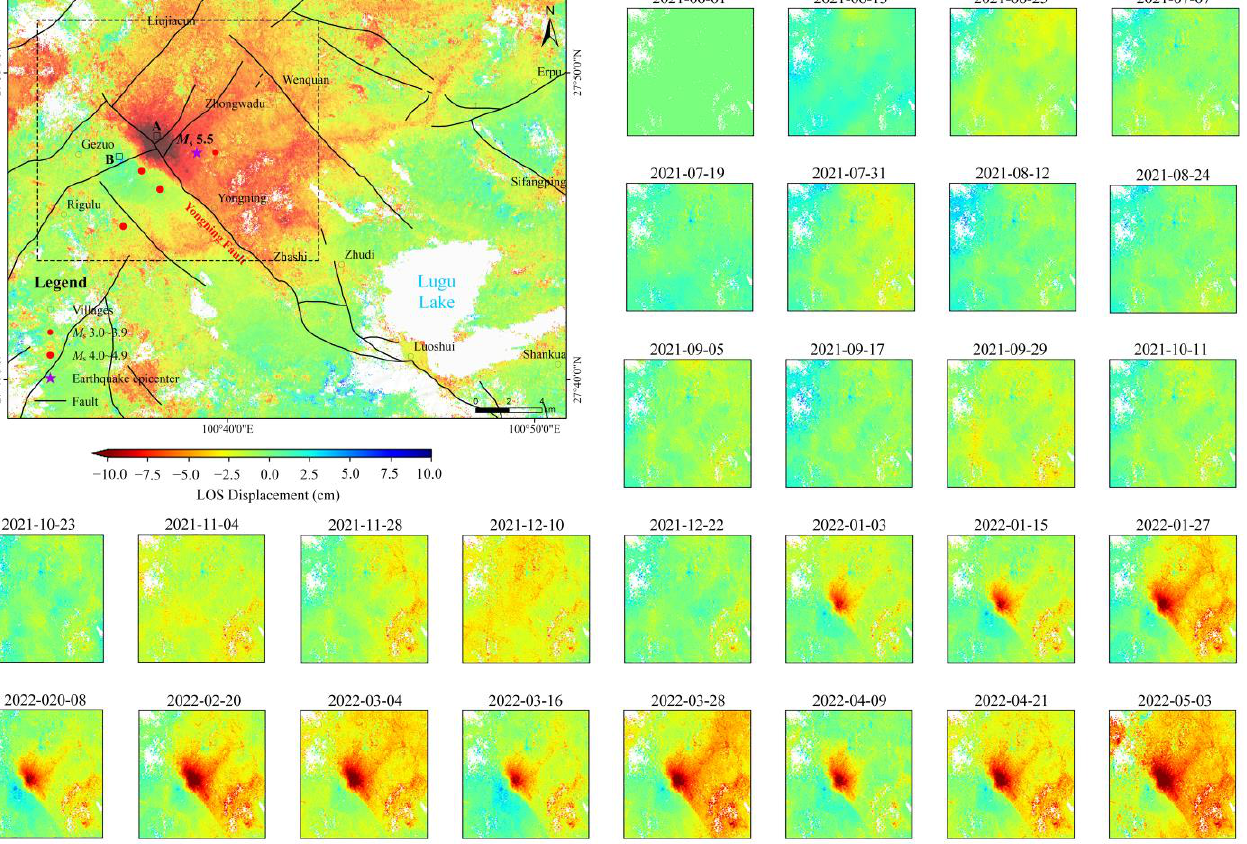
Figure 6. The displacement time series before and after the earthquake of the ascending InSAR; A and B are the areas where the 20 selected deformation points (A 1 – A 10 , B 1 – B 10 ) in Figure 7 are located.